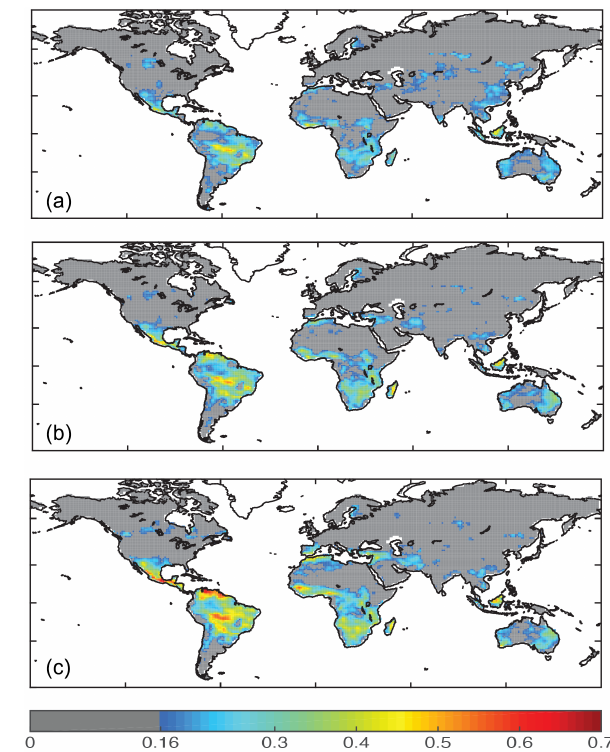
Figure 4. Mean of the models for the fraction of the time during which the annual mean LAI is considered “Low” (model projected annual mean LAI is less than 1standard deviation of the current mean at each gridbox) is shown for 2011–2030 (a) , 2041–2060 (b) and 2081–2100 (c) for RCP85, where the current mean and stan- dard deviation are defined for each grid box for 1981–2000. For the current climate, the fraction of time below 1standard deviation will be 0.16, which is colored in gray, so all colors represent an increase in low